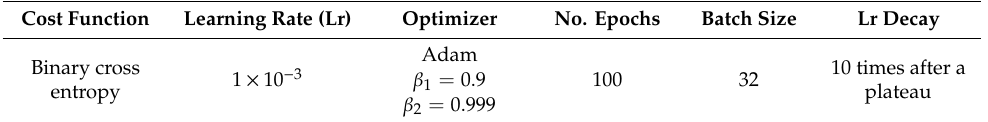
Table 2. Network